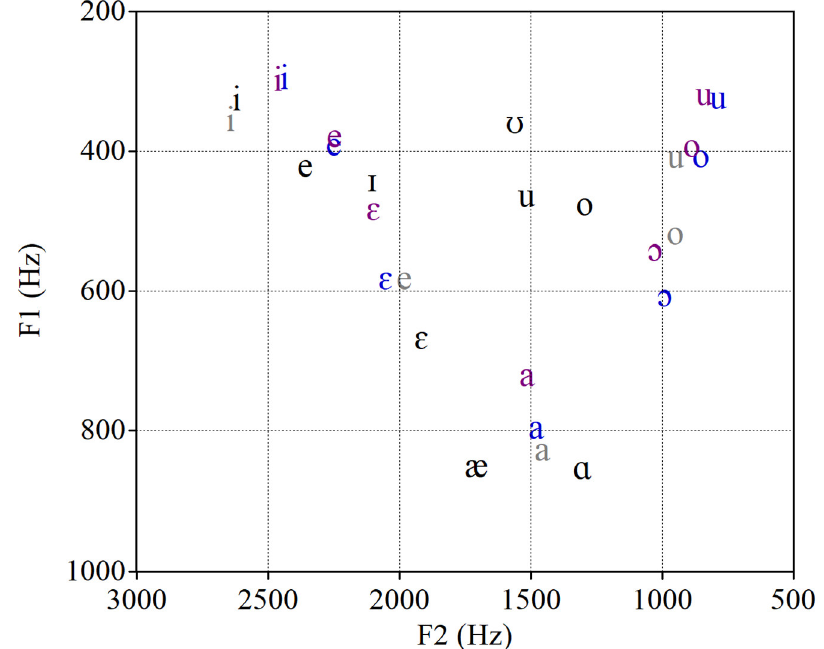
Figure 1. Southern-Californian English monolinguals’ production of English (black; Hagiwara 1997) together with Californian English bilinguals’ production of Mexican Spanish vowels (gray; Grijalva et al. 2013) compared against Brazilian Portuguese (BP; blue) and European Portuguese (EP; purple) vowels (Escudero et al. 2009a). Note: All formant values were averaged across male and female speakers.